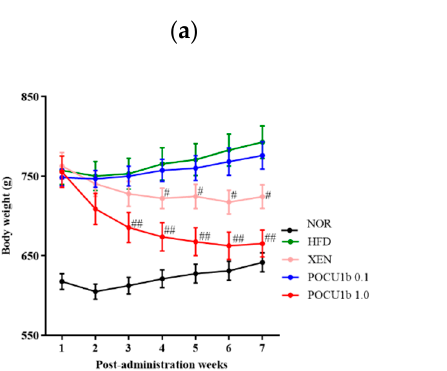
Figure 3. E ff ects of POCU1b on body weight loss and food intake in high-fat diet (HFD)-fed Figure 3. Effects of POCU1b on body weight loss and food intake in high ‐ fat diet (HFD) ‐ fed rats. ( a ) body weight. ( b ) Food intake. After induction of the obese SD rats by feeding with 45% fat for 13